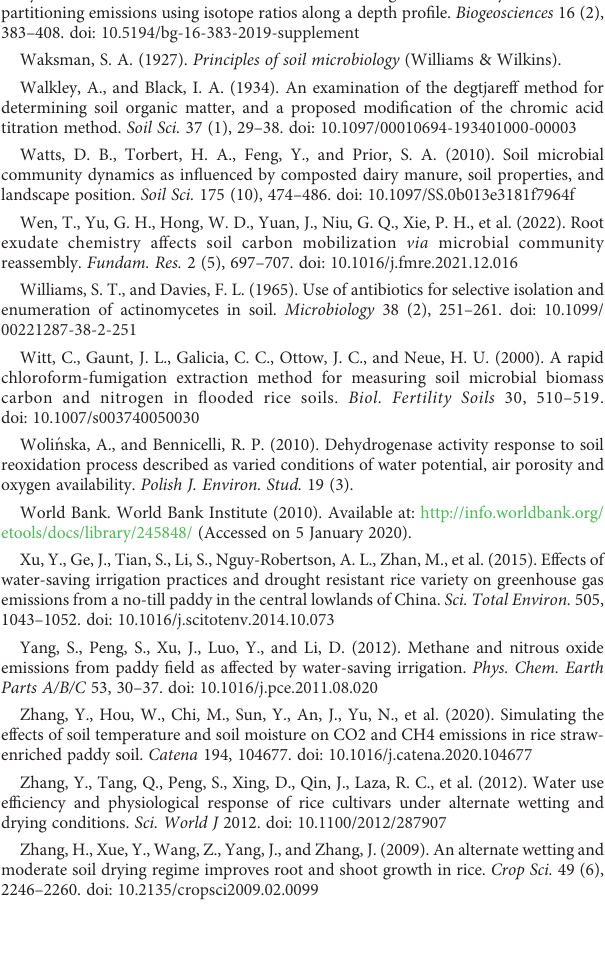
Tabatabai, M. A. (1972). Use of p-nitro-phenyl phosphate for assay of soil phosphatase activity. Soil Biol. Biochem. 4, 479 – 487. doi: